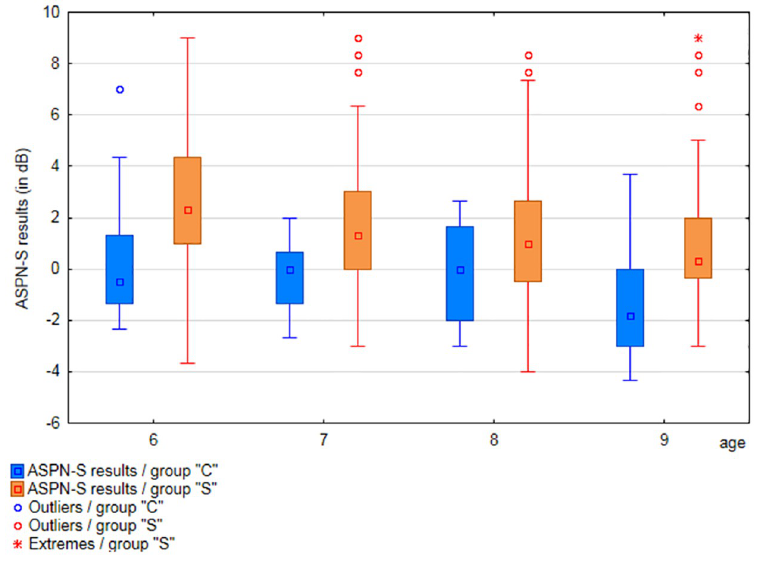
Fig 3. Comparison of the ASPN-S test results, among age groups, in groups”C” and”S”.